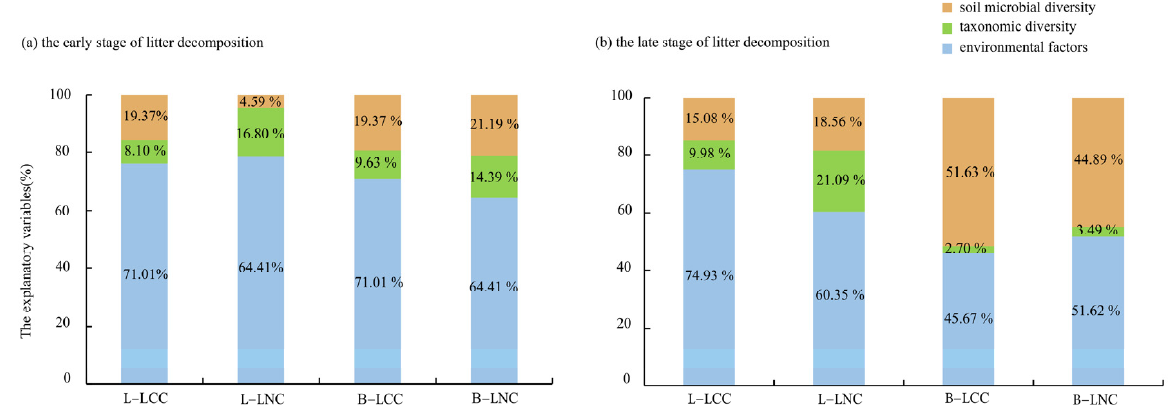
Figure 3. The explanatory variables of factors on litter carbon and nitrogen release in different decomposition stages of litter in canopy gaps. Notes: L − LCC indicates leaf litter carbon content; L − LNC indicates leaf litter nitrogen content; B − LCC indicates branch litter carbon content; B − LNC indicates branch litter nitrogen